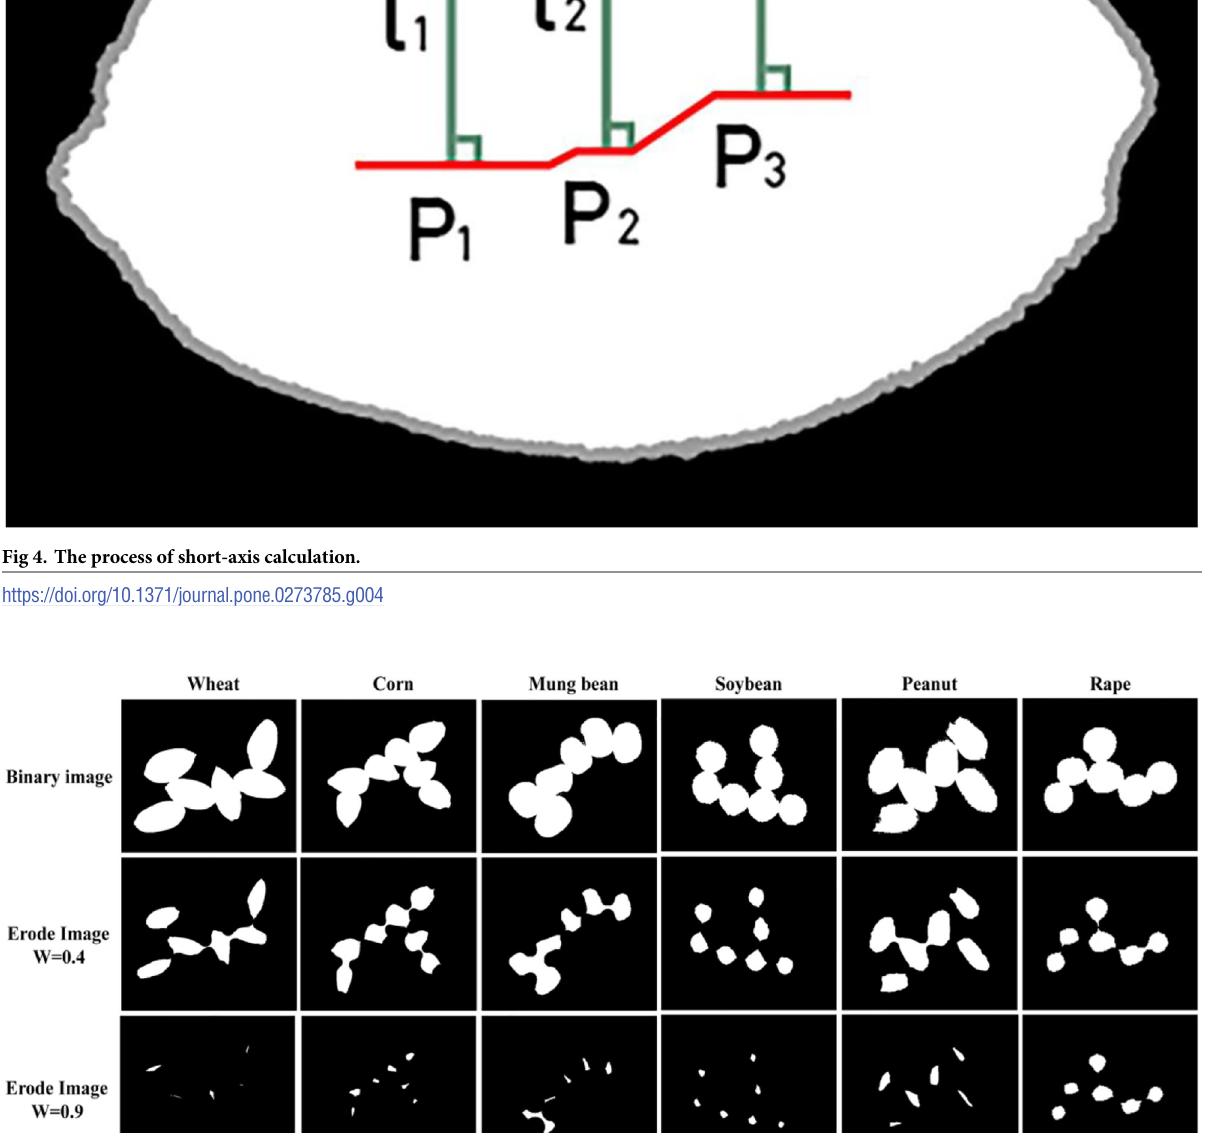
PLOS ONE | https://doi.org/10.1371/journal.pone.0273785 September 14,